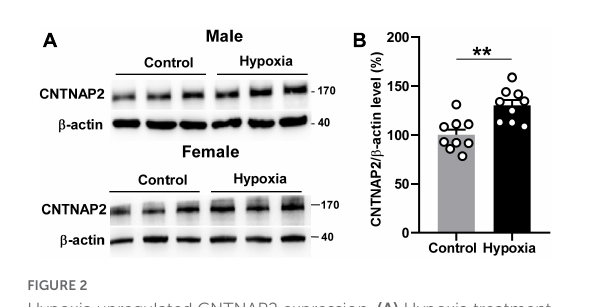
FIGURE2 Hypoxia upregulated CNTNAP2 expression. (A) Hypoxia treatment increased CNTNAP2 expression level in the hippocampus of male and female mice. (B) Quantification of Western Blot results. The ratio of CNTNAP2 to corresponding β -actin protein level was normalized to the average of the control group. The values represent means ± SEM ( n = 6 male + 3 female in each group), ** p < 0.01 by unpaired t